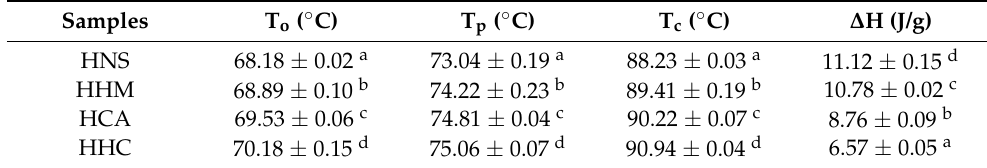
Table 2. Gelatinization parameters of native and modified Hausa potato starch. Samples